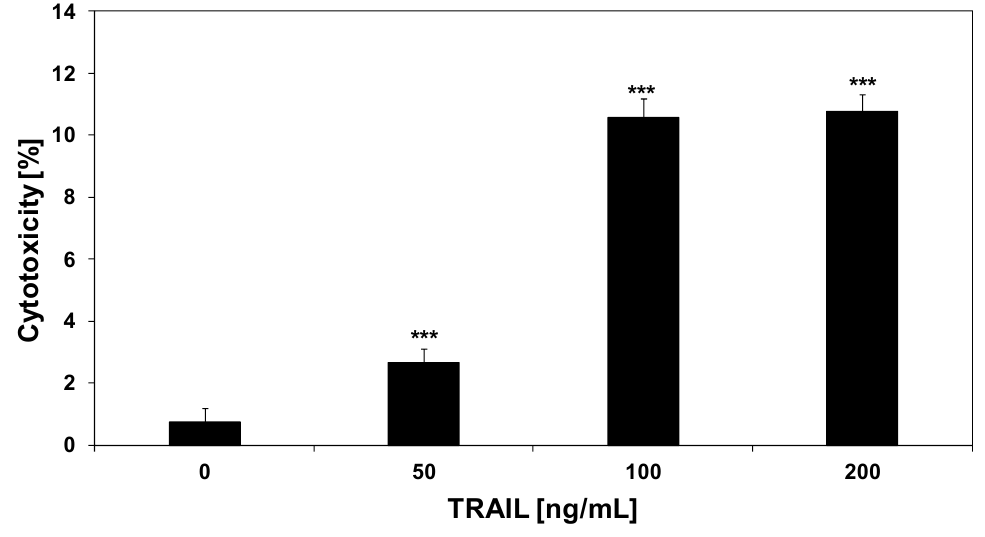
Figure 3. Cytotoxic activity of TRAIL in HeLa cancer cells. The cancer cells were incubated for 48 h with TRAIL at the concentrations of 50–200 ng/mL. The percentage of cell death was measured by MTT cytotoxicity assay. The values represent mean ± SD of three independent experiments performed in quadruplicate (n = 3) ( *** p < 0.001 compared with